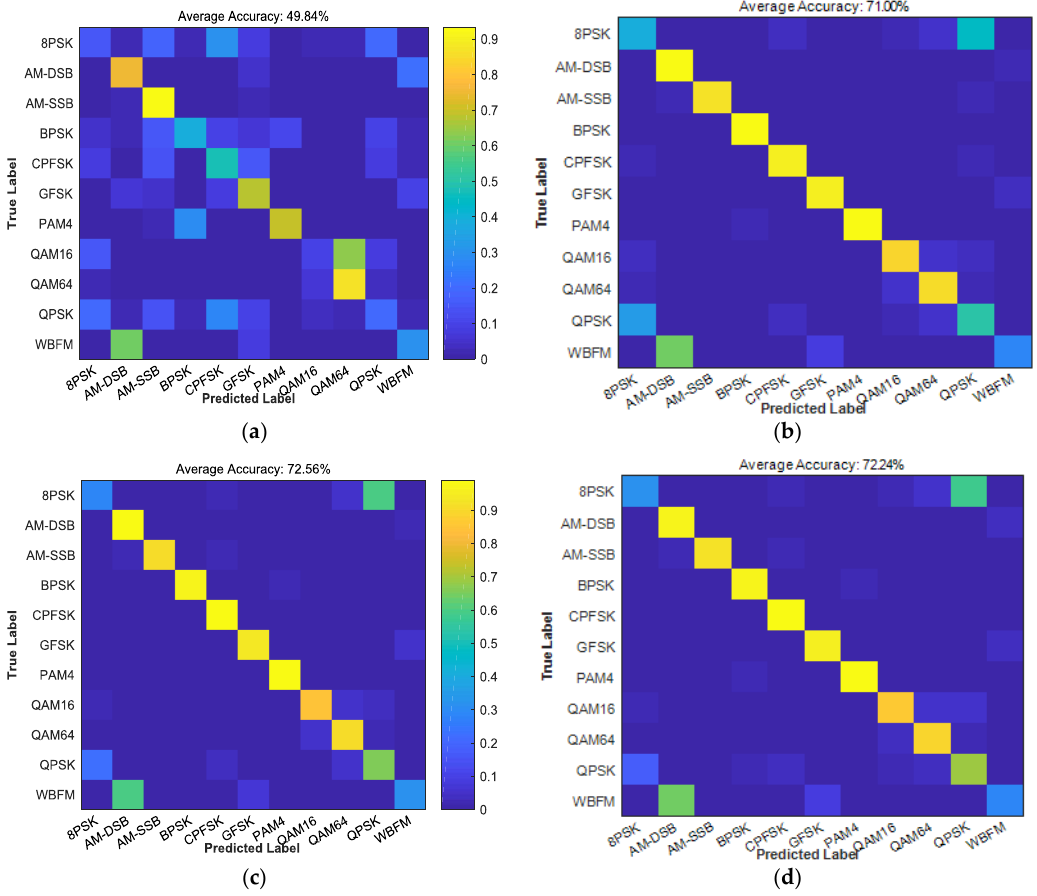
Figure 11. Confusion matrix directly identified from raw radio signal sampling data: ( a ) SNR = −6 dB; ( b ) SNR = 0 dB; ( c ) SNR = 6 dB; ( d ) SNR = 16 dB.